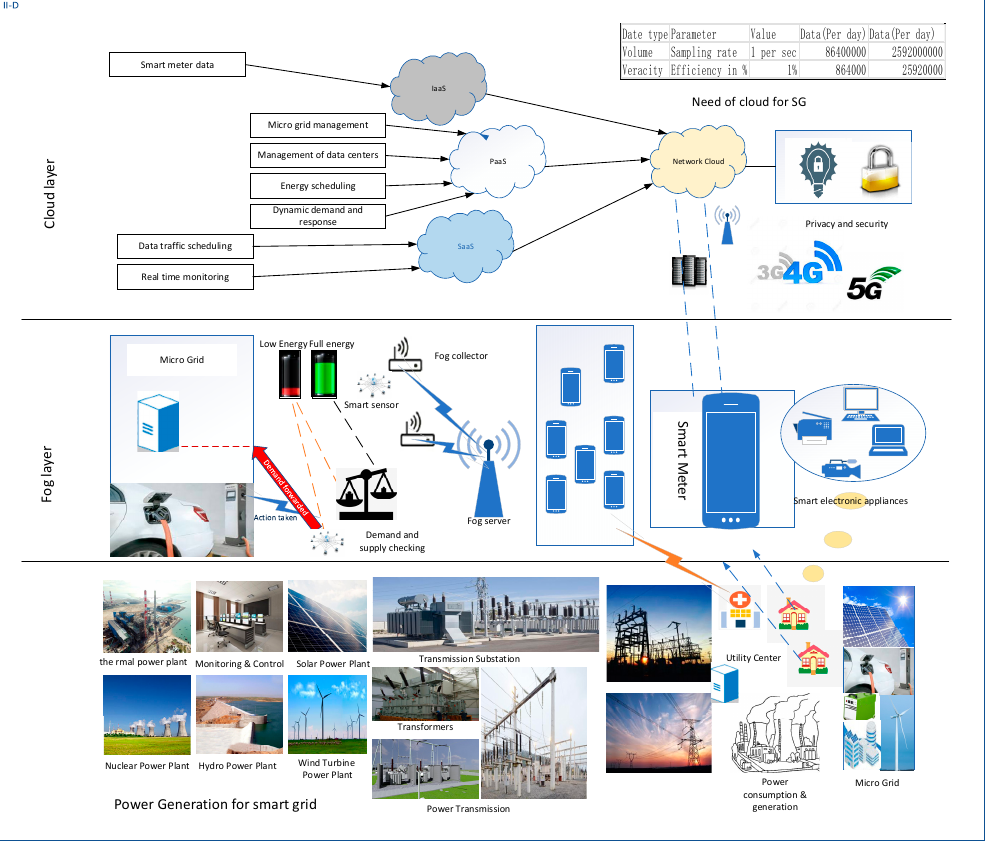
Figure 3. Three-tier architecture of smart grid with cloud computing (CC) and fog computing (FC).